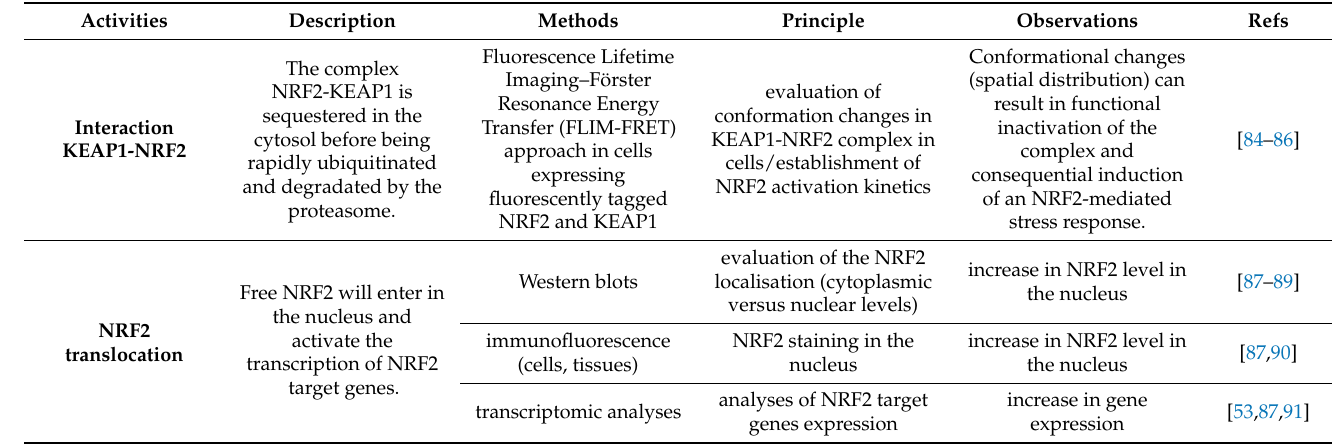
Table 1. Methods for NRF2 activity